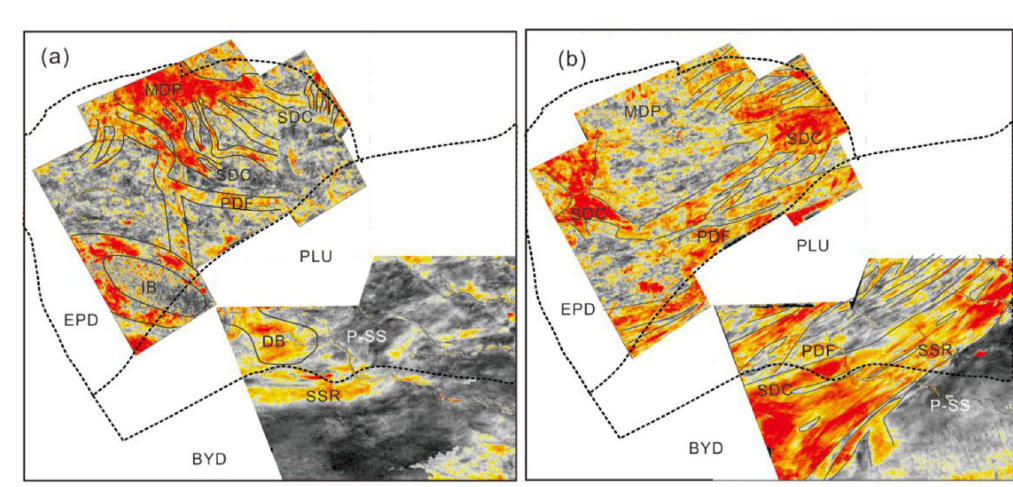
Figure 8. Depositional interpretation of the root mean square amplitude slice of the river-controlled meandering delta deposits in the Highstand systems tract in S5 ( a ) and wave-controlled meandering river delta deposits in the Highstand systems tract in S7 ( b ). The river-controlled delta was bird-foot shaped and the subaqueous distributary channels exhibited a bigger curvature than that of the wave-controlled delta, which was